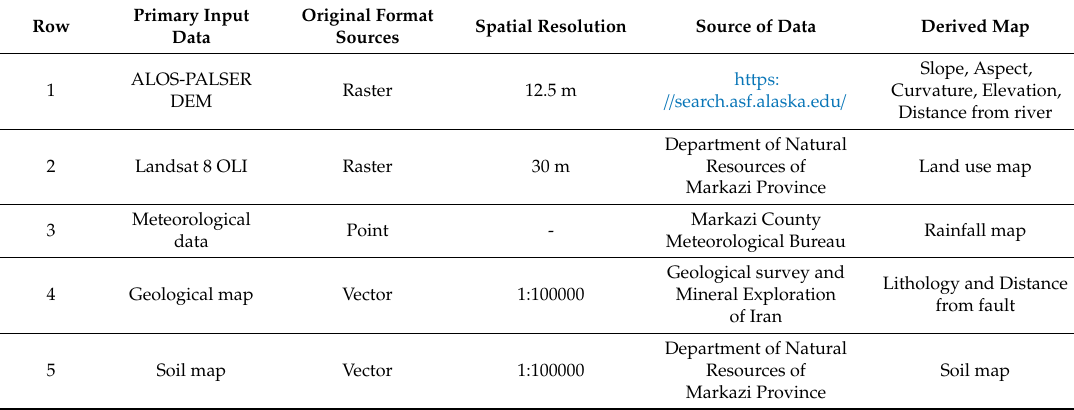
Table 1. Data collection and